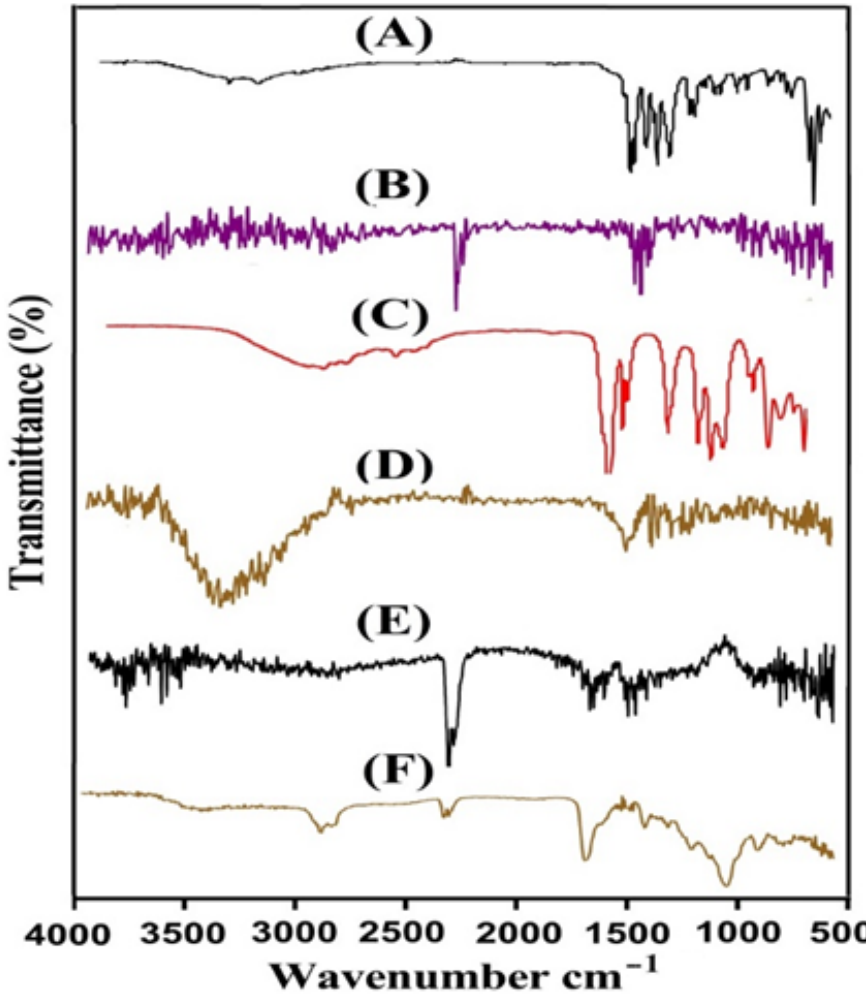
Figure 4. FTIR spectra of ( A ) Cs, ( B ) Sps, ( C ) Aca, ( D ) unloaded Cs/SpsCpAca hydrogel, ( E ) Ibu, and ( F ) loaded Cs/SpsCpAca hydrogel.